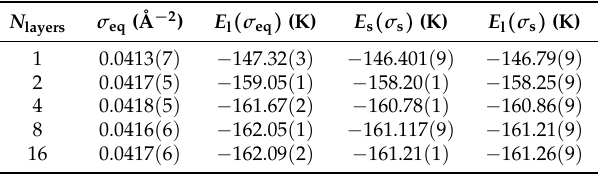
Table 9. The corresponding data to Figure